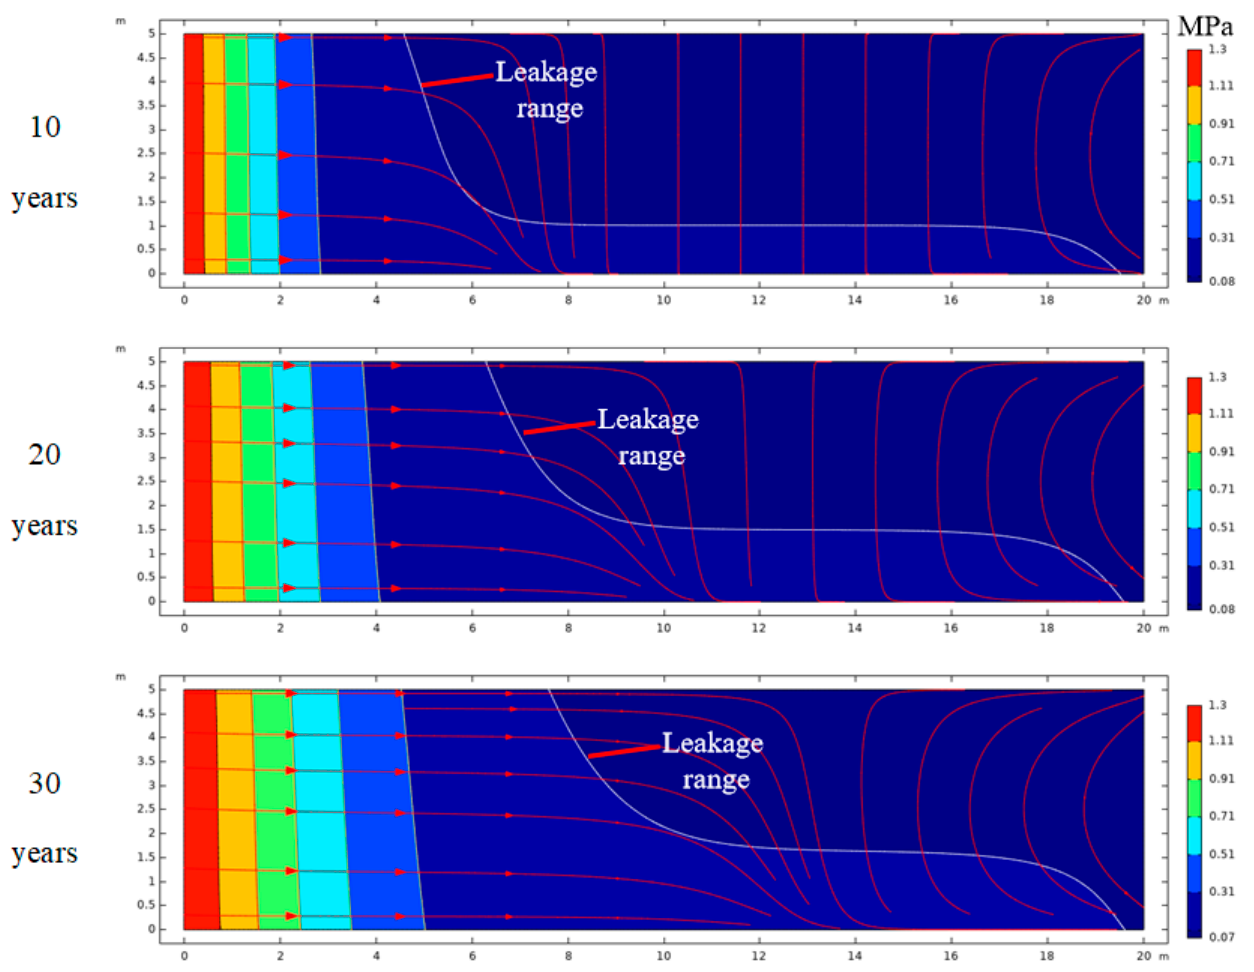
Figure 2. Evolution of leakage range in the coal pillar dam with the depth of 100 m (Unit: MPa).